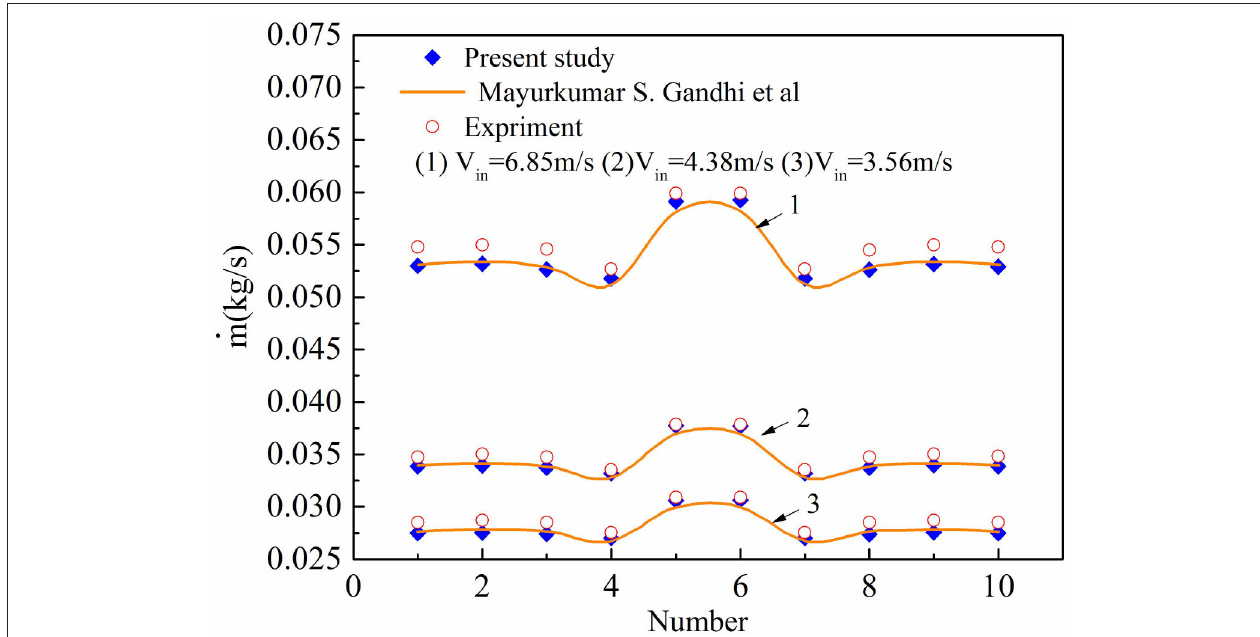
FIGURE 6 | The validation of the simulation results.